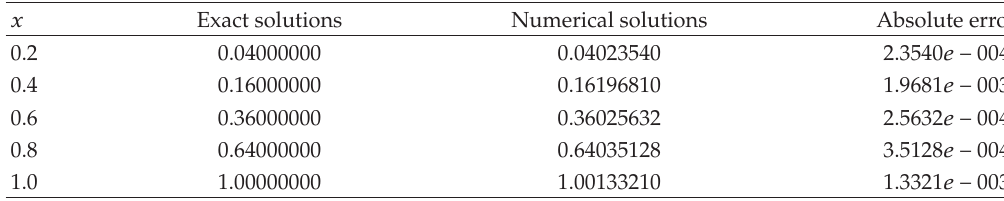
Table 2: Exact and numerical solutions of Example 6.3 for N (cid:8) 2, M (cid:8)